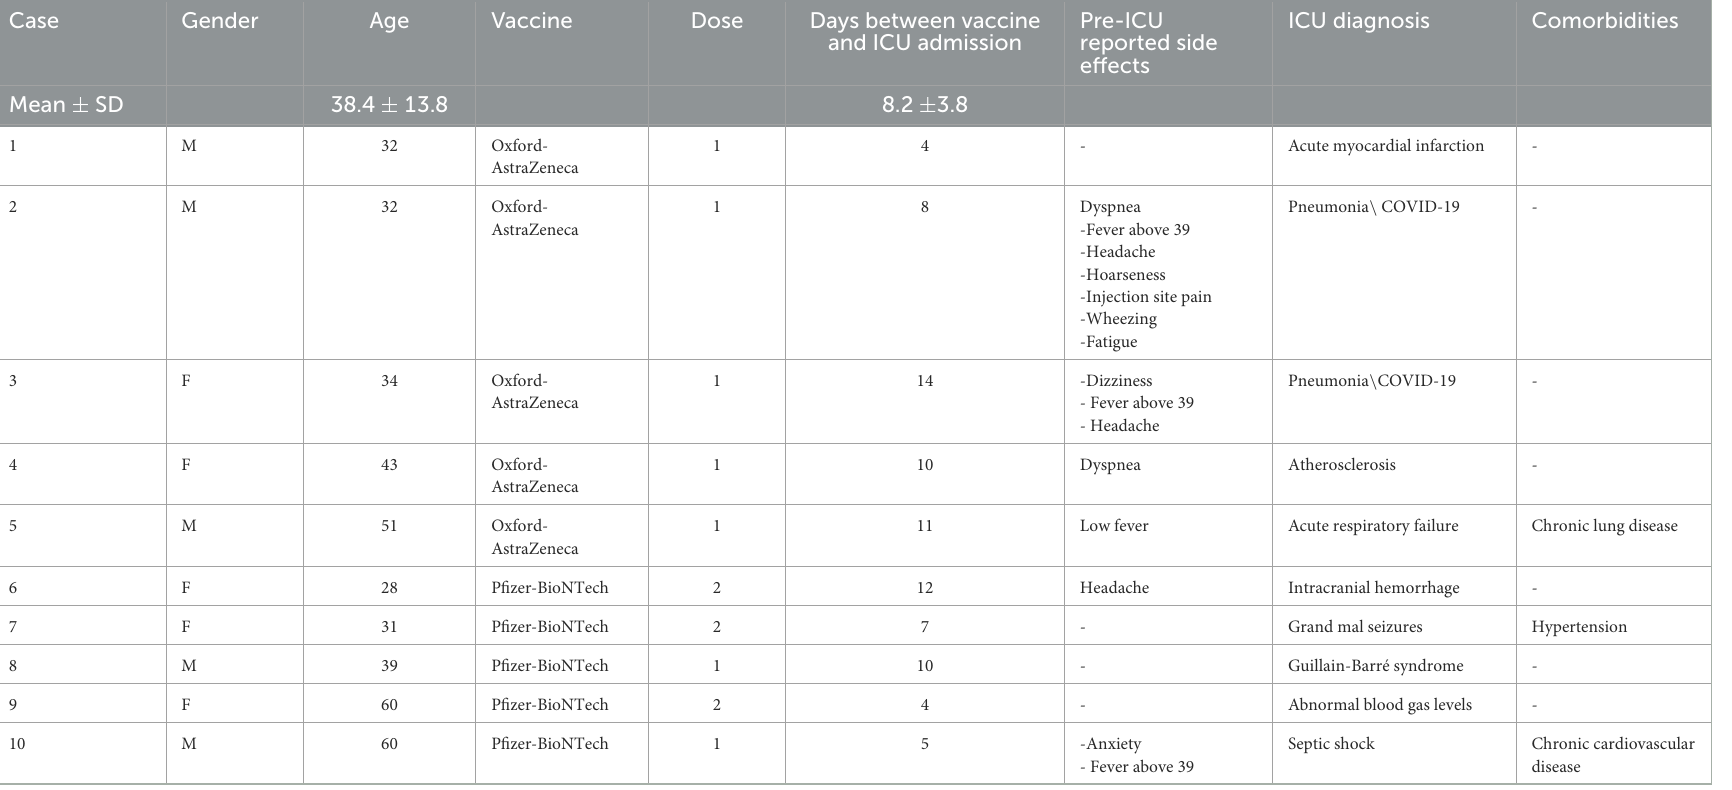
TABLE 5 ICU Admissions post COVID-19